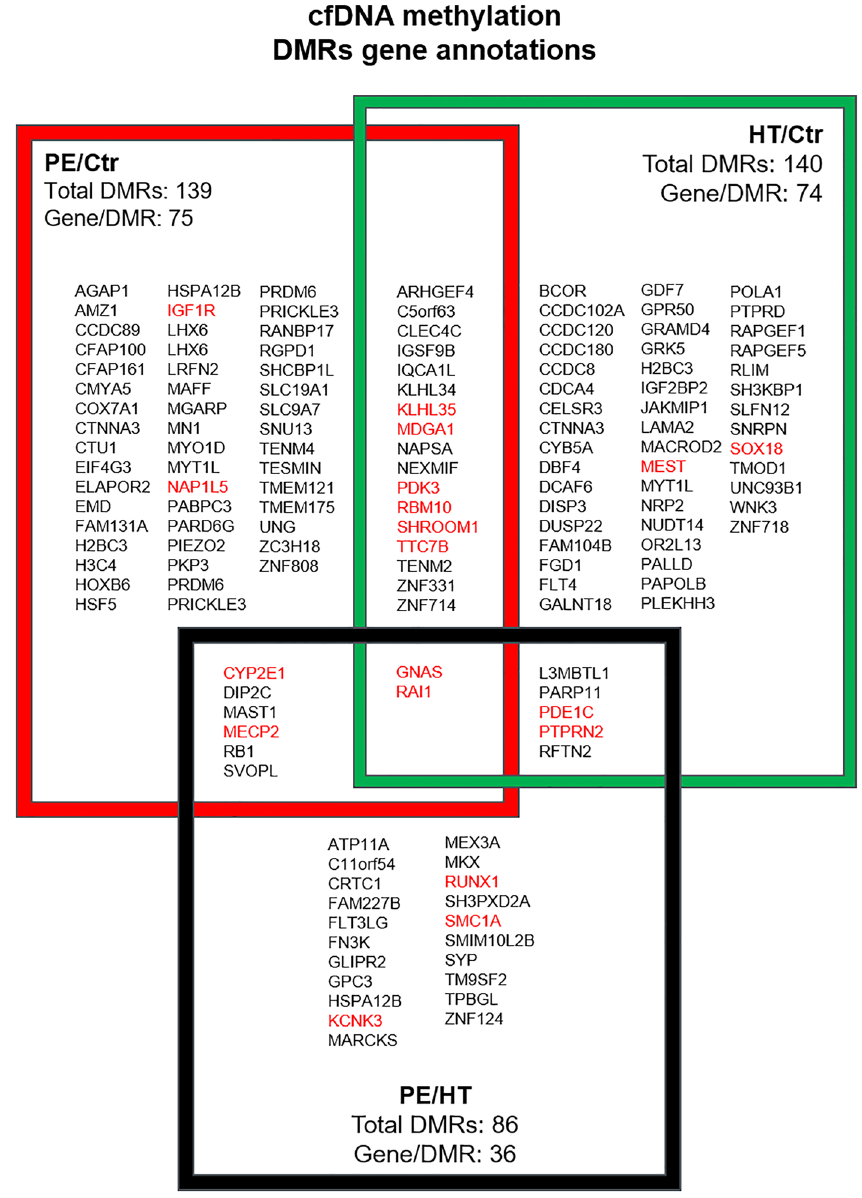
Figure 3. Detailed cfDNA methylation DMRs/Genes. We summarize the significant DMRs and annotated genes in each pairwise comparison (the adjusted p value is < 0.059 between all three groups (n = 5 for each group). PE/Ctr genes are bordered in red, the HT/Ctr in green and PE/HT in black. Annotated genes associated with cardiovascular disorders are highlighted in red. Differentially Methylated Regions (DMR); Preeclampsia (PE) Hypertension (HT); Control